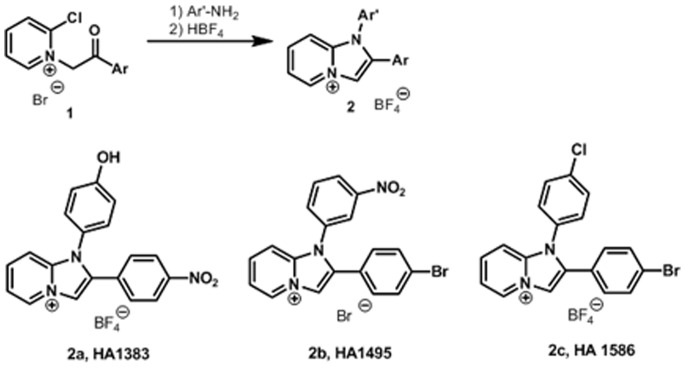
Synthesis and structure of the three heterocyclic model compounds HA1383, HA1495 and HA1568.1-(4-hydroxyphenyl)-2-(4-nitrophenyl)imidazo[1,2-a]pyridinium tetrafluoroborate (HA1383); 1-(3-nitrophenyl)-2-(4-bromophenyl)imidazo[1,2-a]pyridinium bromide (HA1495); 1-(4-chlorophenyl)-2-(4-bromophenyl)imidazo[1,2-a]pyridinium tetrafluoroborate (HA1568).